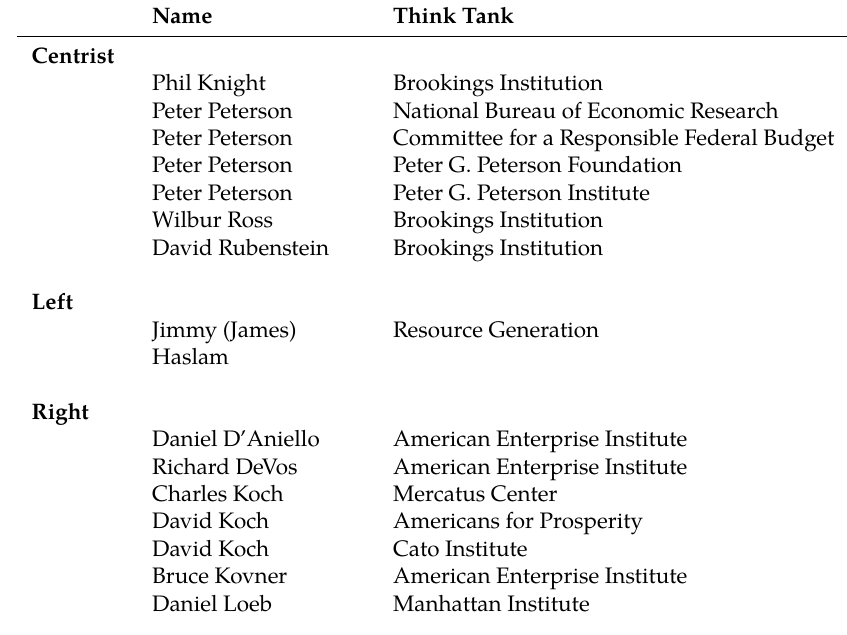
Table 6: Forbes 400 billionaires serving on tax policy think tank boards,